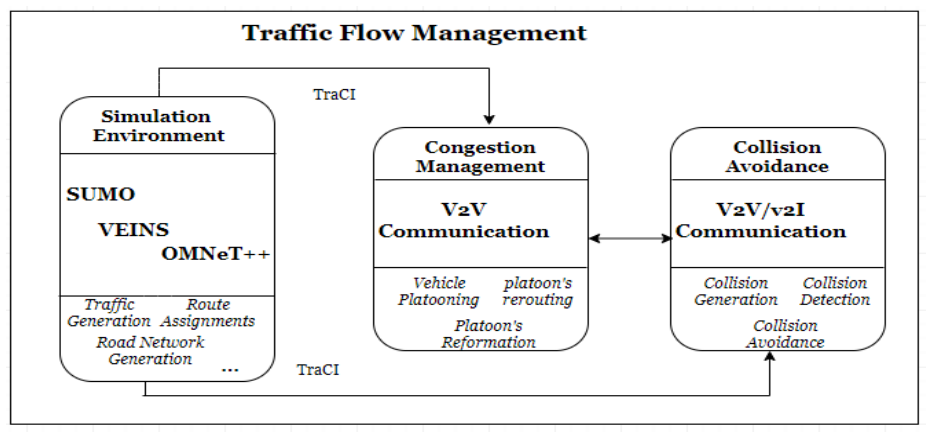
Figure 1. Proposed approach: traffic flow management by congestion management and collision avoidance using simulation